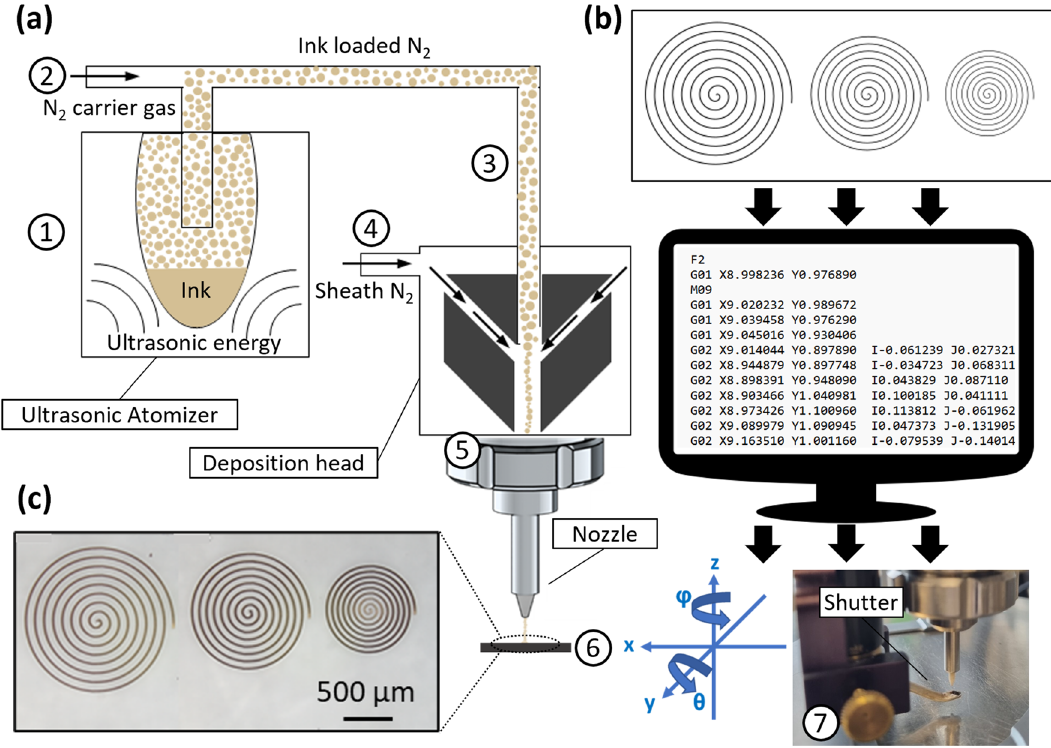
Figure 1. ( a ) A schematic of the AJP process using an ultrasonic atomiser. (1) The material, formulated as an ink, is ultrasonically atomised. (2) An inert gas (N 2 ) is used to increase the pressure in the atomiser chamber. (3) The aerosol is transported to the deposition head with the carrier gas. (4) The aerosol is focused and accelerated by a further annular sheath of inert gas. (5) The resulting high velocity jet is deposited onto the